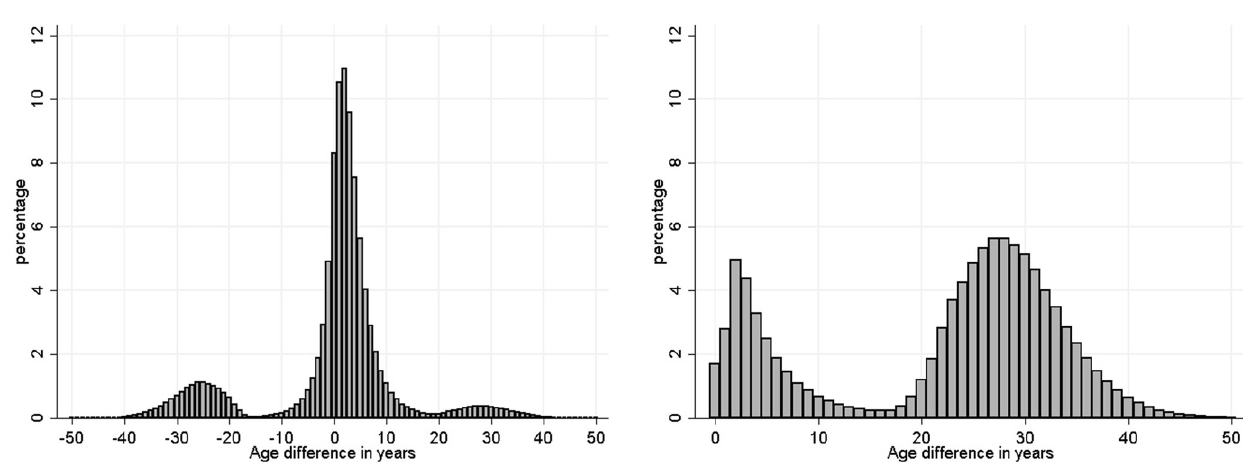
Fig. 3 Distribution of age differences of matches, male/male. (Note: Includes all male-male pairs of individuals who we were able to match by location and name (according to our name-matching algorithm). Age difference is calculated as older age – younger